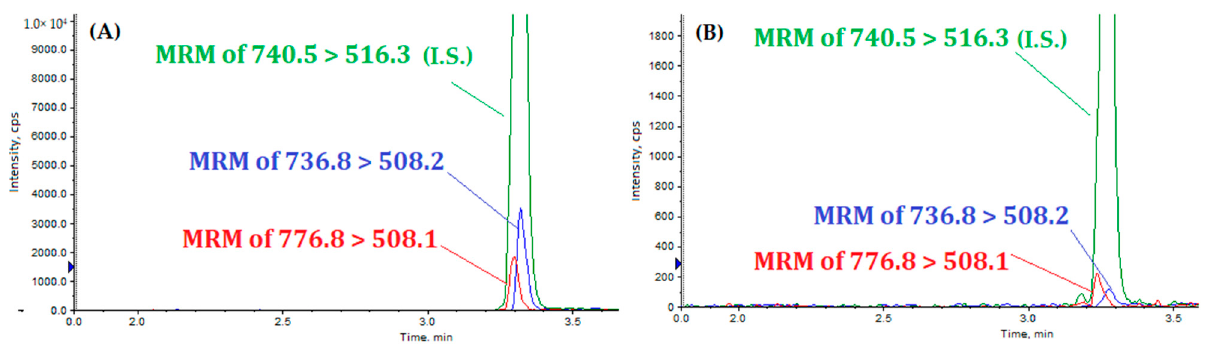
Figure 3. ( A ) Extract ions chromatograms of MQQNGYENPTYK(Lys13C6,15N2) (green:I.S.), MQQNGYpENPTYK (red), and MQQNGYENPTYK (blue) in HELA cells; ( B ) extract ions chromatograms of MQQNGYENPTYK(Lys13C6,15N2) (green), MQQNGYpENPTYK (red), and MQQNGYENPTYK (blue) in AD patient.